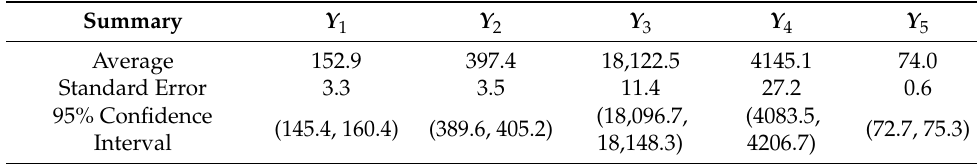
Figure 3. Number of individuals in different states for baseline scenario.